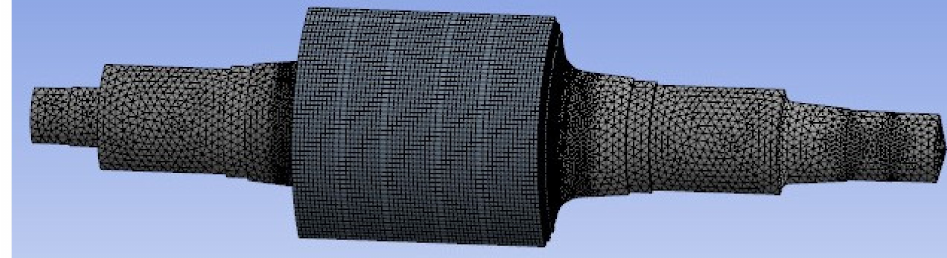
Figure 5. Finite element model of extrusion